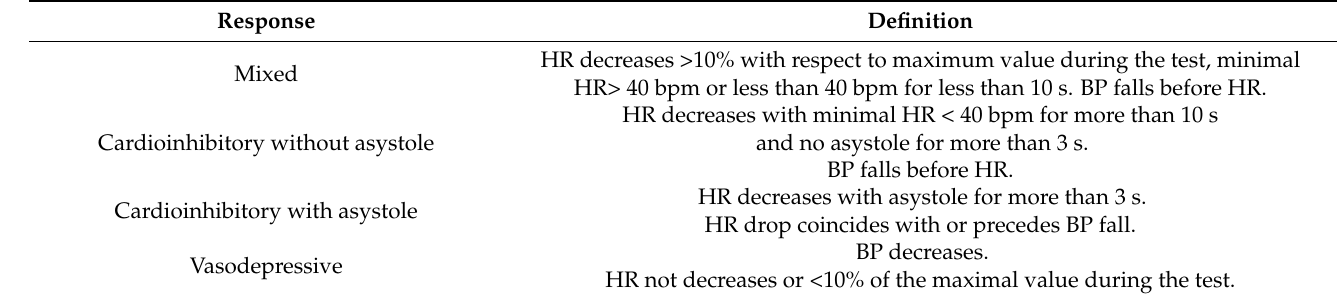
Table 1. Classification of head-up tilt test-induced vasovagal